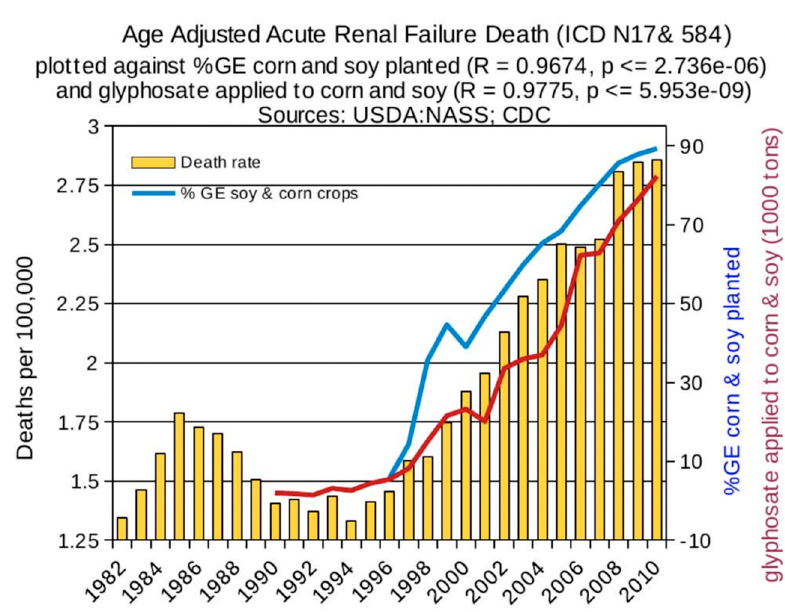
Figure 3. Correlation between age-adjusted renal failure deaths and glyphosate applications and percentage of US corn and soy crops that are GE. (From Swanson et al., 2014) [61].